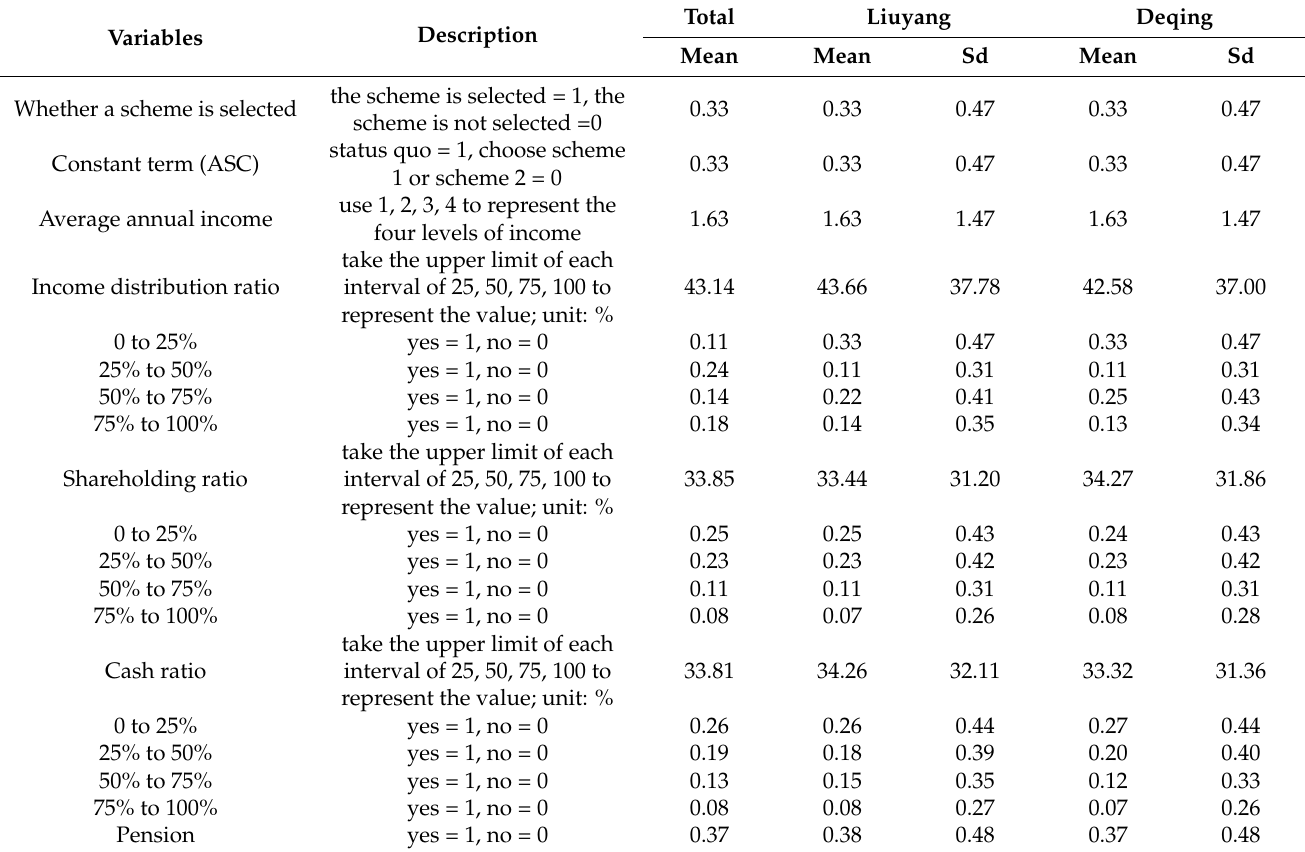
Table 4. Variable description and